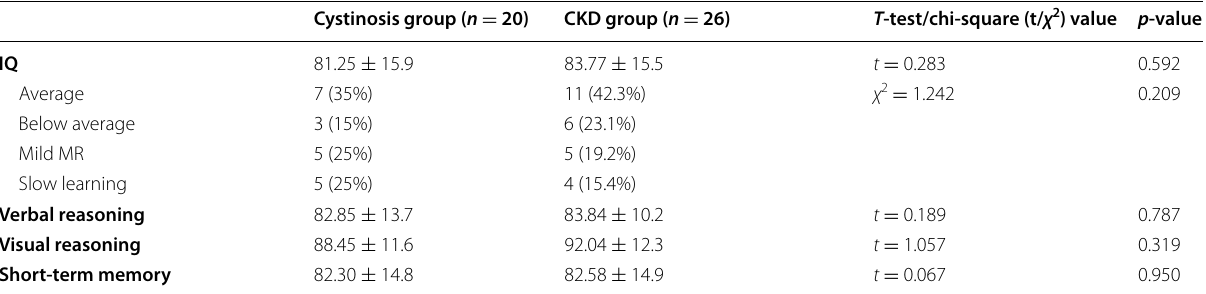
Independent t -test was used to compare difference in mean between groups ( t ). Chi-square test was used to compare the difference in frequencies among groups ( χ 2 ) CKD chronic kidney disease, IQ intelligence